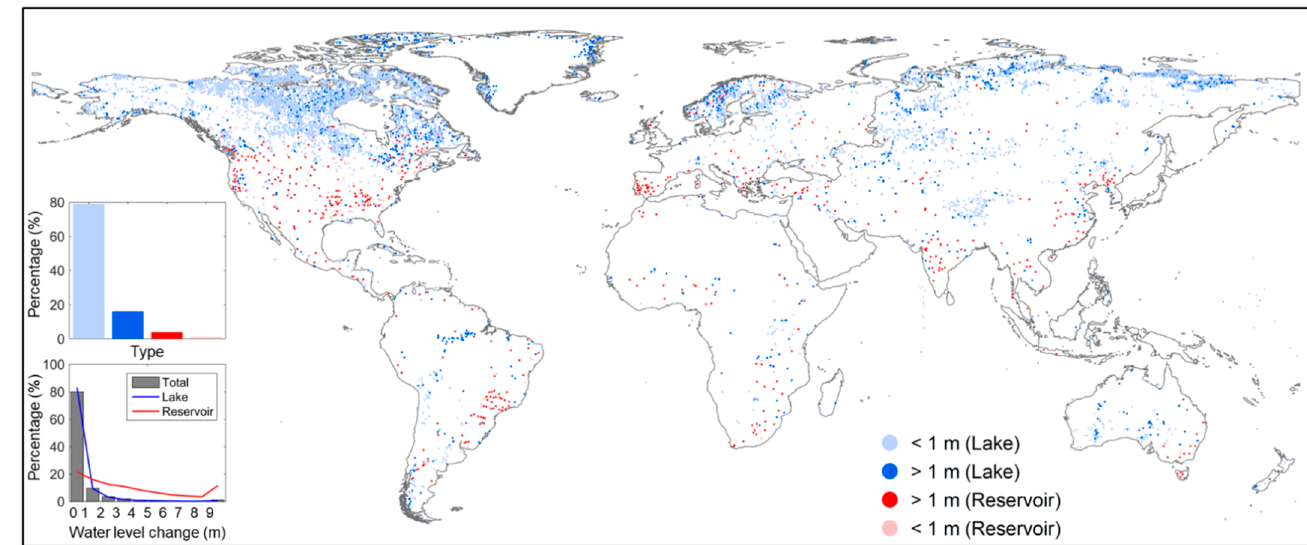
Figure 2. Global patterns of monthly water level changes of lakes and reservoirs in 2019 derived from ICESat-2 ATL13 products. In total, 13,843 lakes (13,148) and reservoirs (695) marked by dots were included, and these water bodies have valid ICESat-2 observations in all seasons. Four types of dots (detailed in the legend) were used to characterize the monthly water level changes of lakes and reservoirs during 2019. The first subset shows percentages of four types of lakes/reservoirs’ monthly level changes, and four bins correspond to four kinds of dots used in the legend. The second subset illustrates percentages of lakes/reservoirs with different monthly water level changes in 2019. From two subsets, approximately 80% of water bodies have a monthly water level change lower than 1 m (as the classification criteria in Figure 2).